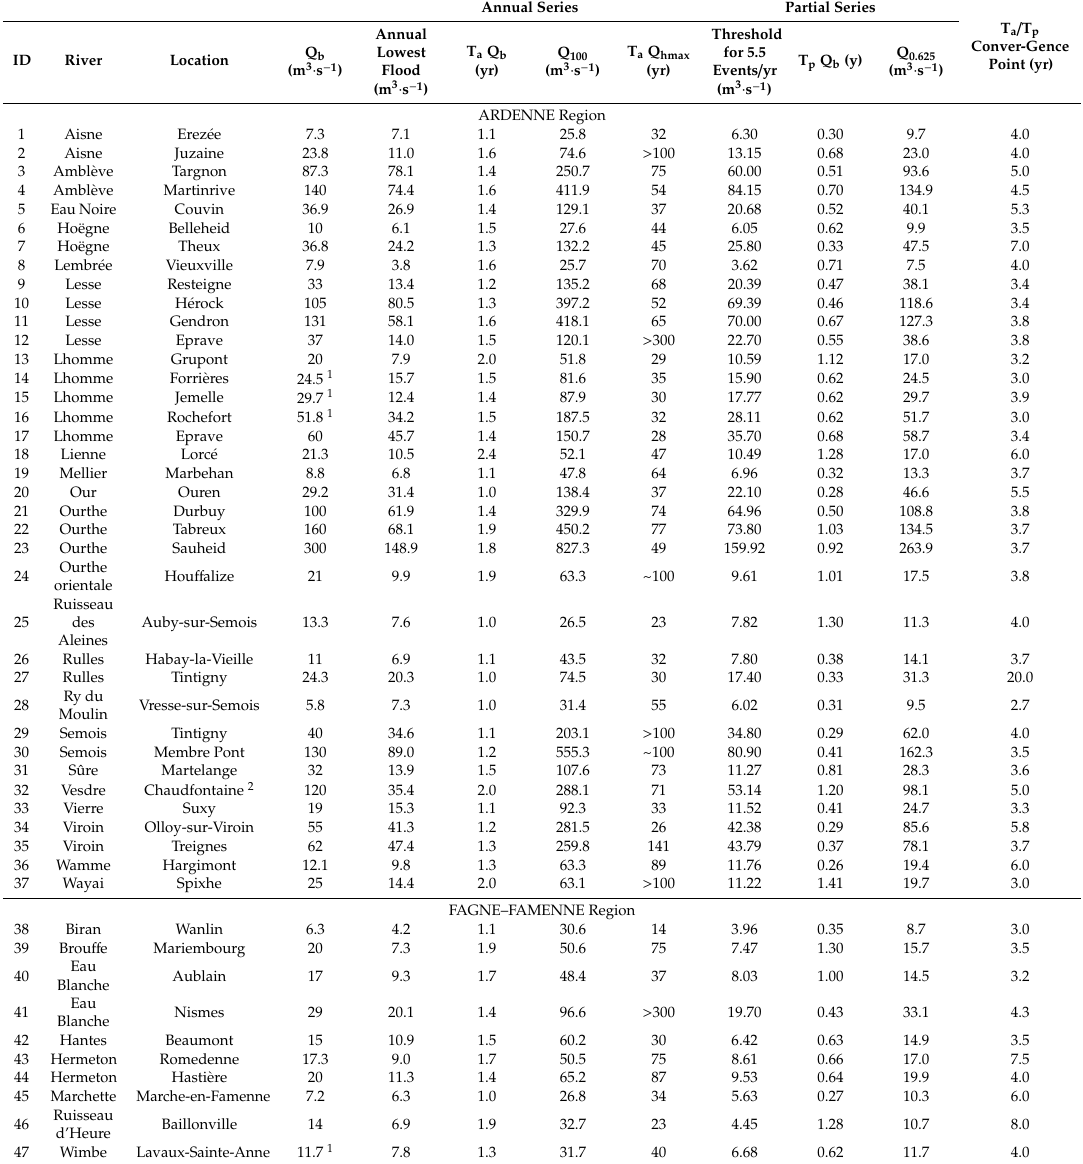
Annual Series Partial Series